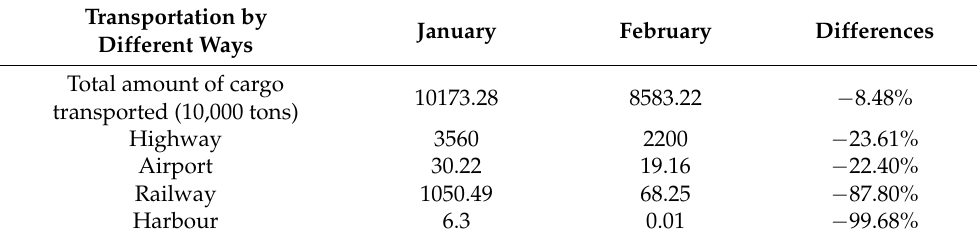
Table 1. Traffic control in January and February of 2020 in Shanghai from Shanghai Bureau of